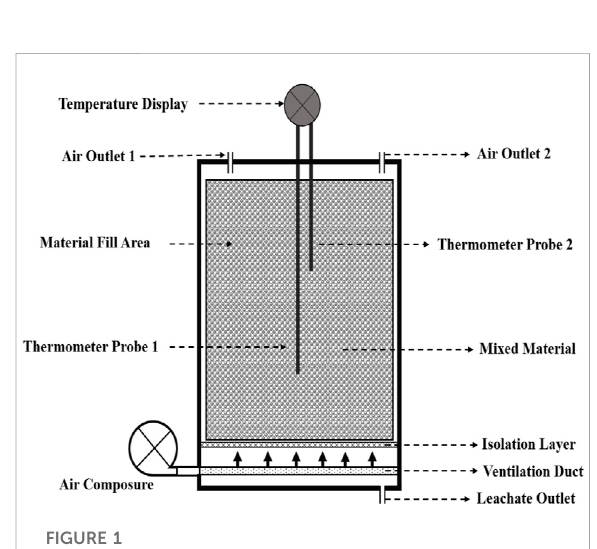
FIGURE 1 Schematic diagram of the lab-scale forced ventilation circular cylinder reactor (100 L